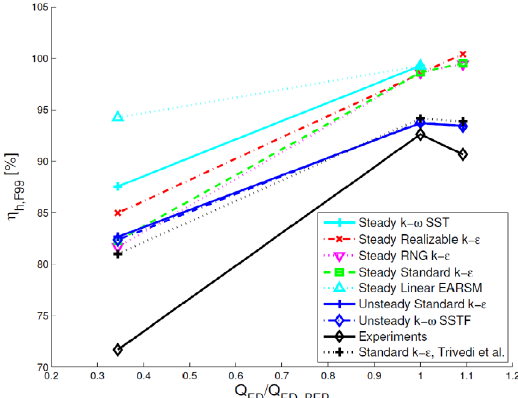
Fig. 2. Comparison of experimental and numerical values of hydraulic ef fi ciency at the part load, BEP, and high load operating conditions, Stoessel [9].